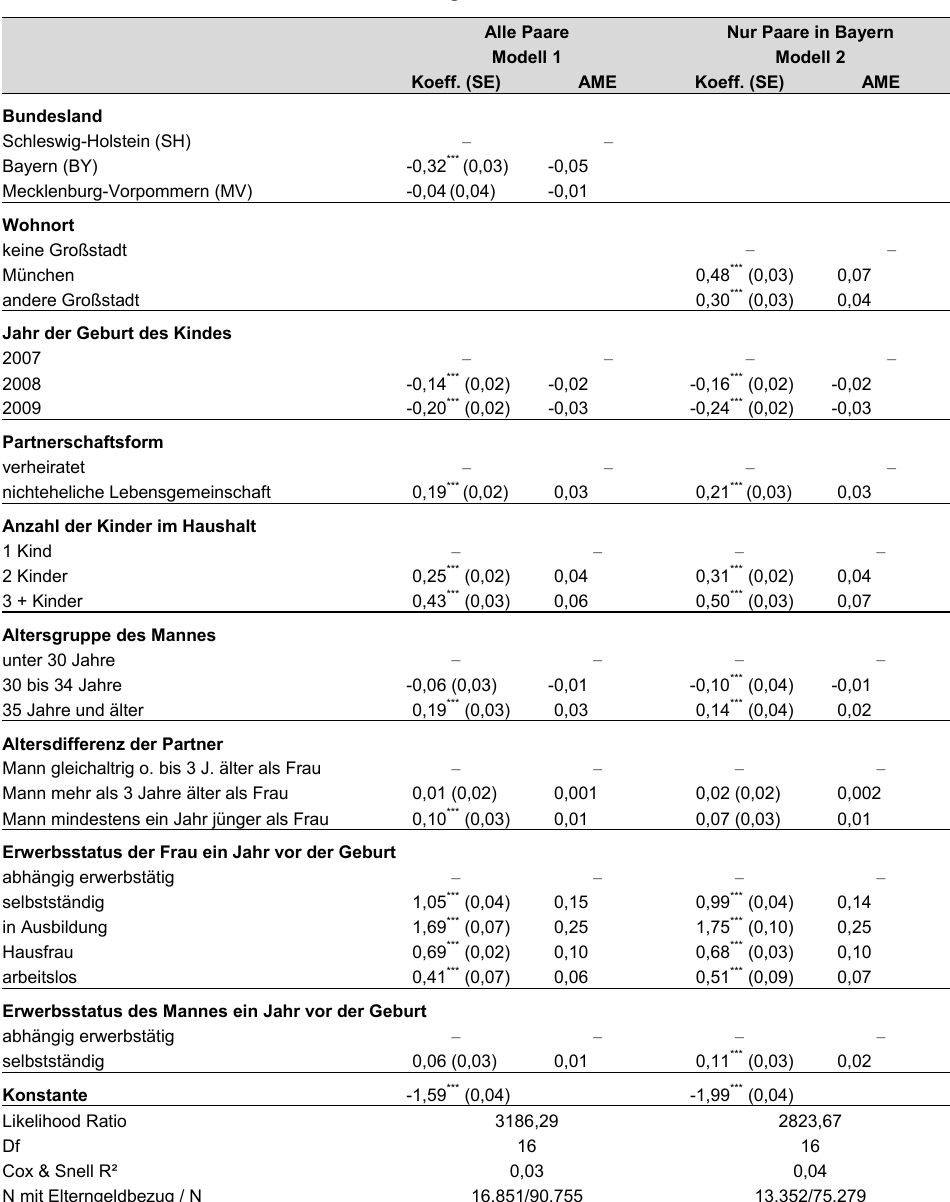
H. Trappe: Väterzeit ‒ das Elterngeld als Beschleuniger der Gleichstellung? 252 Tabelle 2 : Determinanten eines mehr als zweimonatigen Elterngeldbezugs durch vor der Geburt des Kindes erwerbstätige Partner in BY, MV und